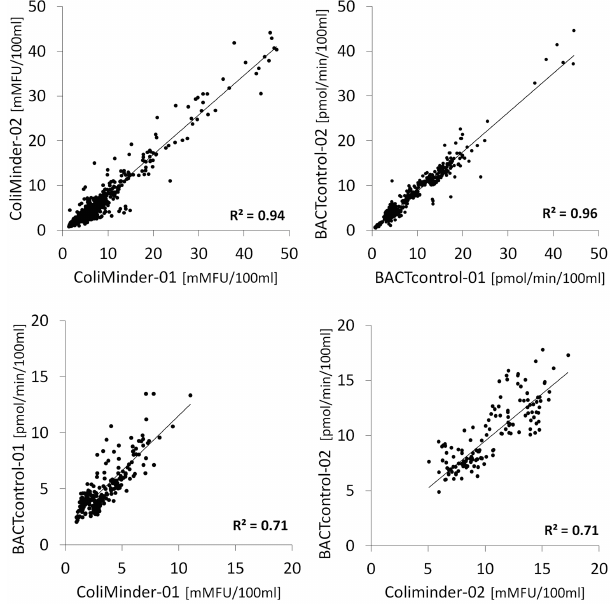
Figure 13. Hypothesis testing example 4: consistency of online monitoring of microbial faecal pollution by GLUC activity as a sur- rogate. Top panels (Test 1) compare devices with the same design and assay (BACTcontrol vs. BACTcontrol, ColiMinder vs. Coli- Minder). Bottom panels (Test 2) compare devices with different de- signs and assays (BACTcontrol vs. ColiMinder). The smaller range of the bottom panels is related to differences in the measurement pe- riod. All correlations are significant at p values<0.001. See Stadler et al. (2016) for